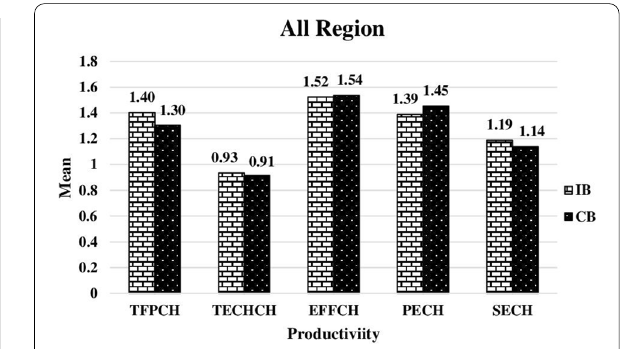
Fig. 9 Levels of productivity in all regions